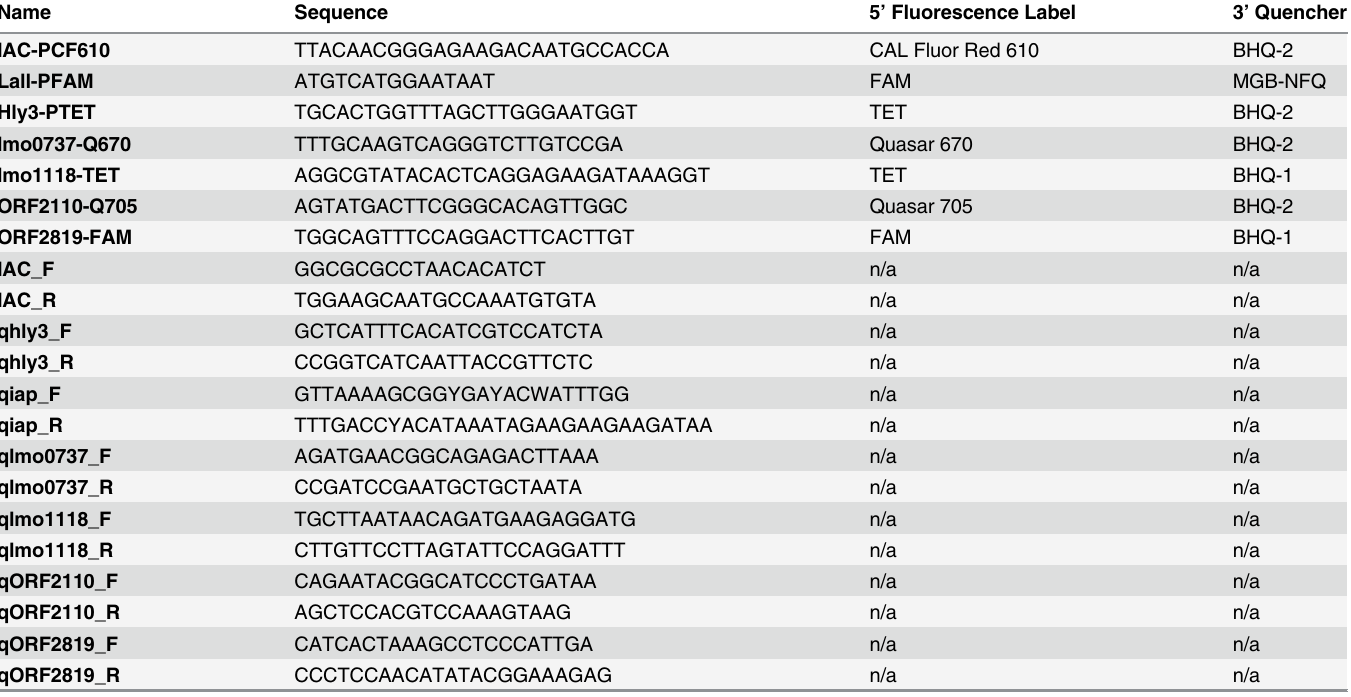
Table 2. qPCR Primers and